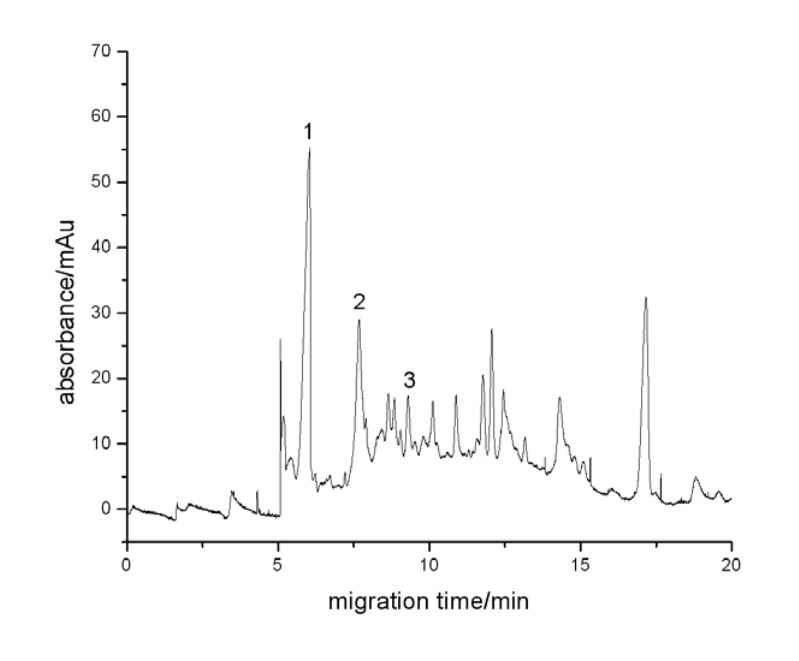
Fig. 4 Capillary electropherogram of Tze Po San Pien Pills. Peaks: 1 = paeoniforin; 2 = paeonol; 3 = censenoside Rg 1 . Analytical conditions: 20 mM borax, 30 mM SDS, pH 9.30, applied voltage 20 kV, sample time 5 s, detection UV 203